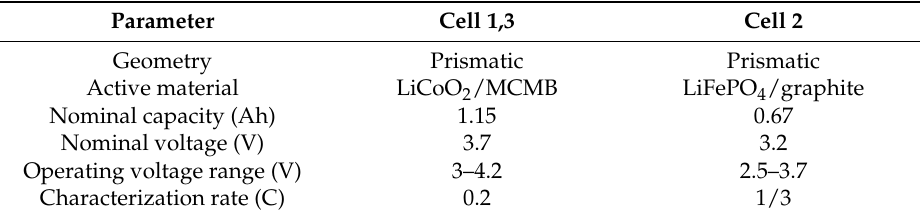
Table 1. Specifications of the three used